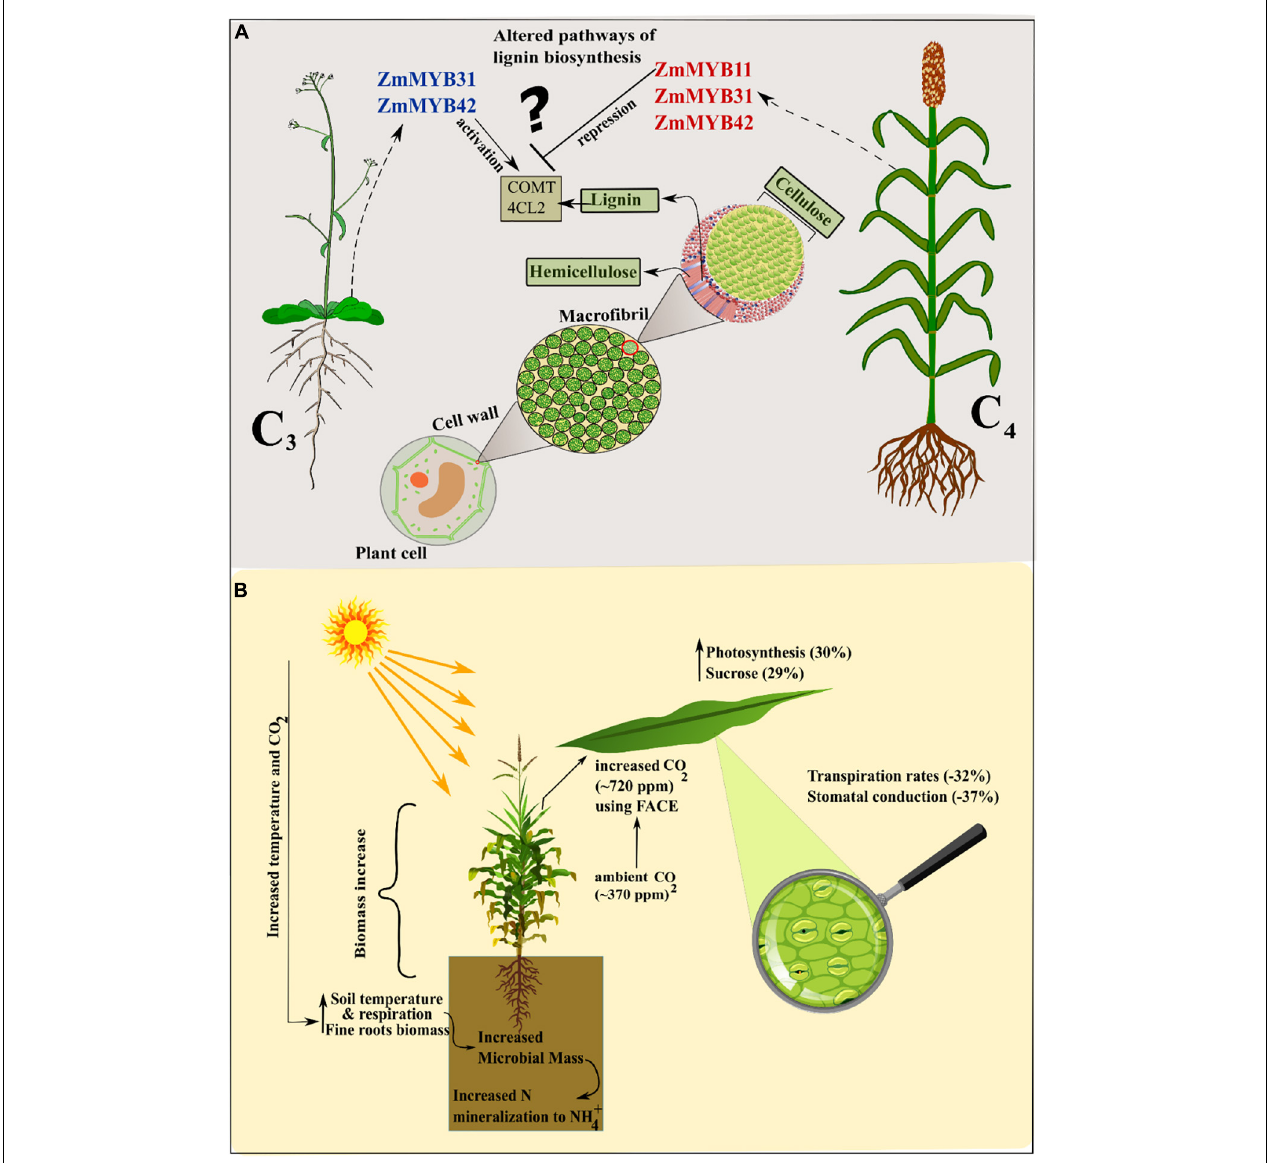
FIGURE 2 | (A) Contrasting transcriptional regulation patterns of MYB TFs in C 3 and C 4 plants. In C 3 ( Arabidopsis ) ectopic expression of maize TFs enhance lignin biosynthesis whereas in C 4 (Maize) lignin content is reduced. This gives rise to lineage-specific transcription in C 4 plants. (B) Increase in temperature and CO